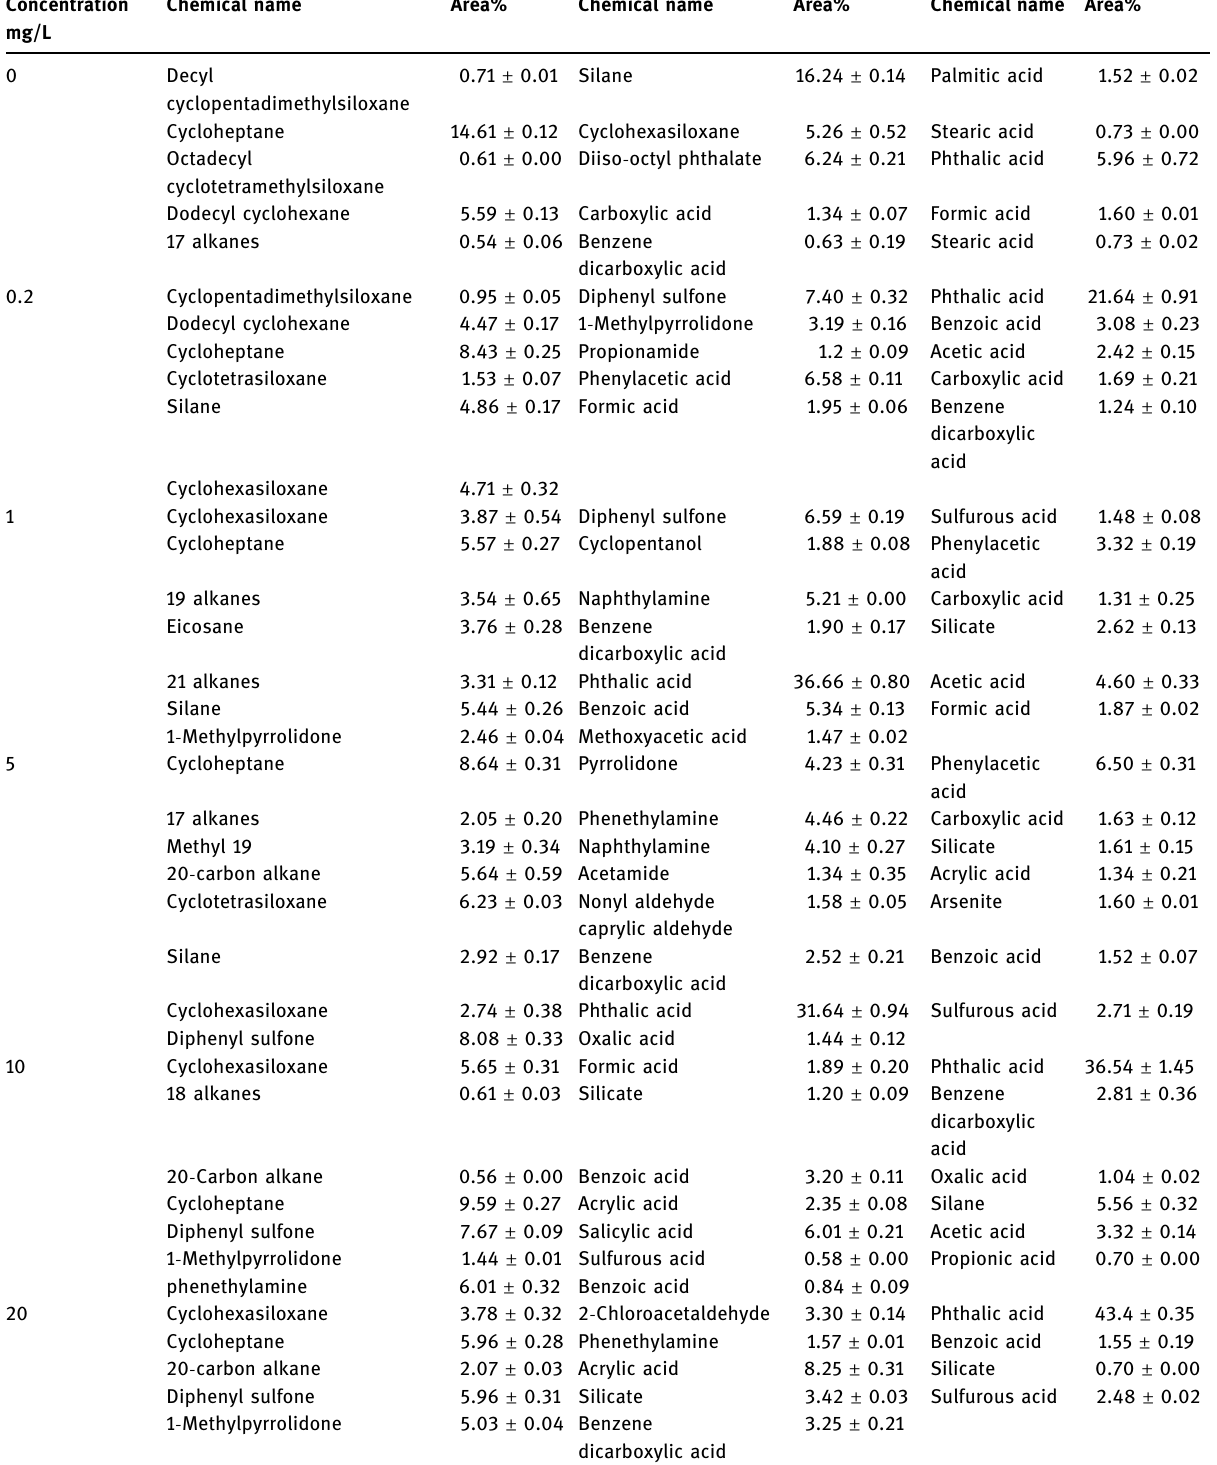
Table 2: Major root exudates of black algae exposed to a concentration gradient of phosphorus Concentration